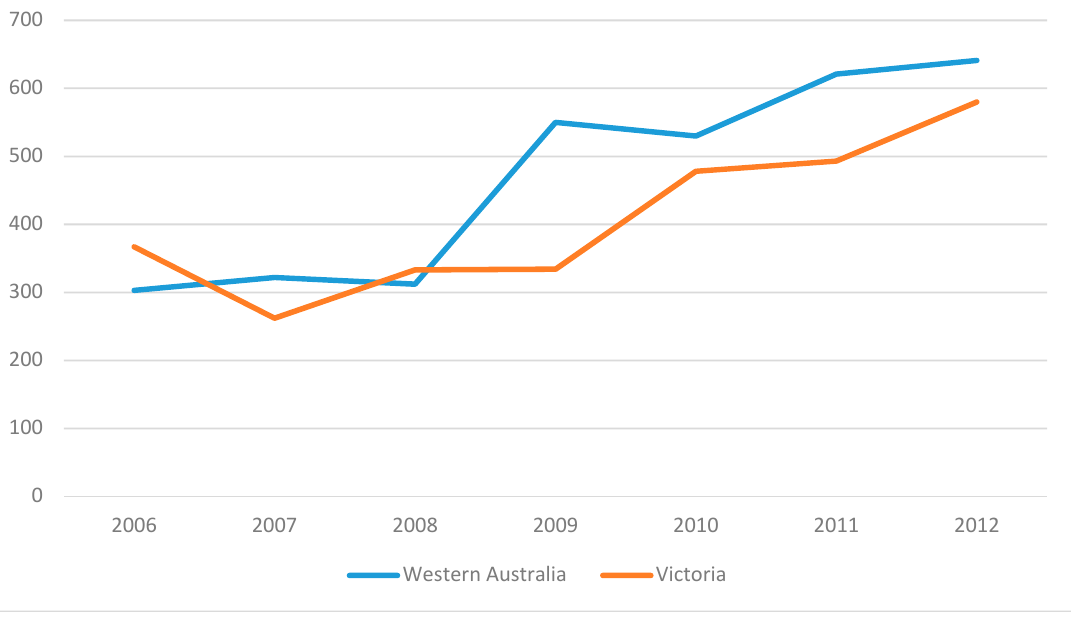
Figure 1. Sexual abuse reports: Western Australia and Victoria 2006–2012 (rate/100,000 children).